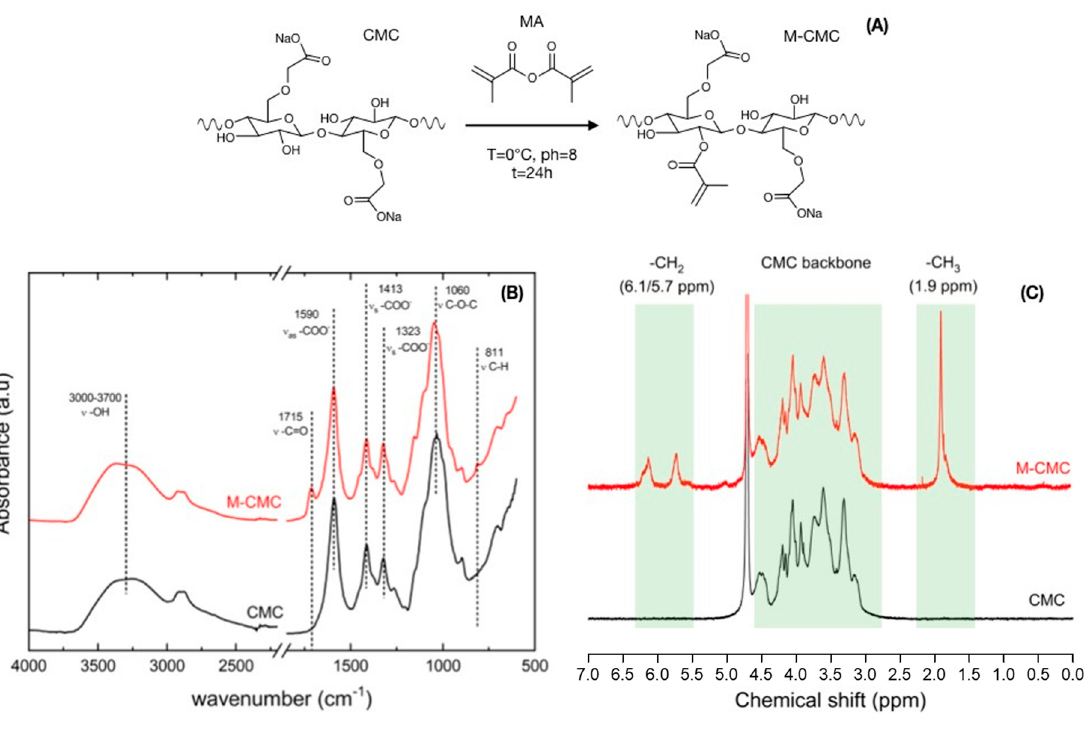
Figure 1. ( A ) Scheme for the methacrylation of carboxymethyl cellulose (CMC). The presented product only presents one of possible reaction products. ( B ) FTIR and ( C ) 1 H NMR spectra for methacrylated CMC (M-CMC, red) and neat CMC (CMC, black).